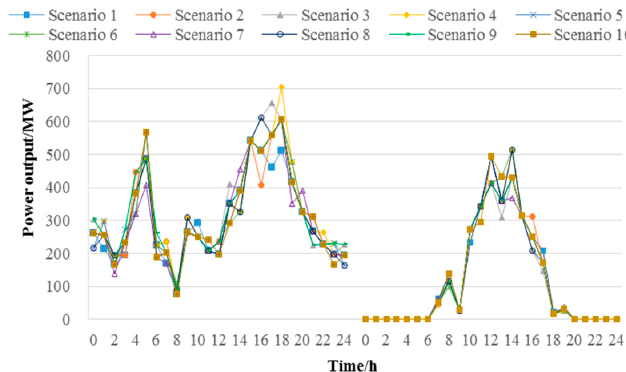
Figure 5. The ten simulation scenarios of WPPs and PVs on a typical load day (summer).